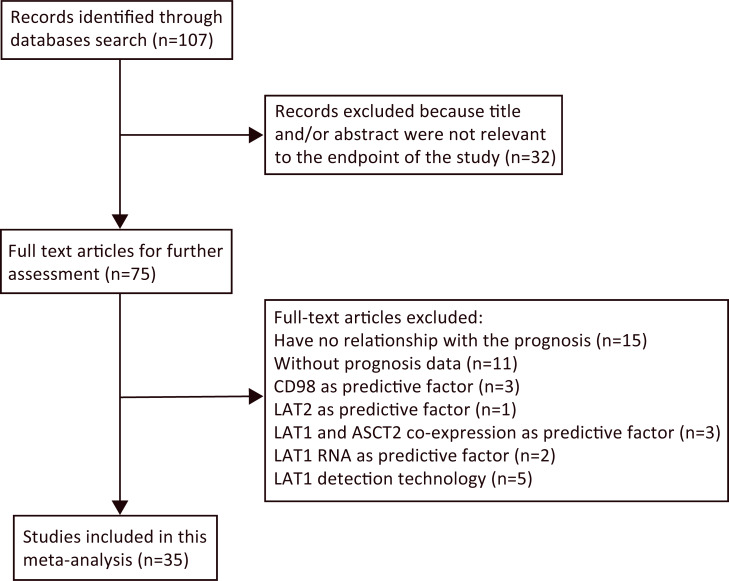
The flow chart of the selection process in our meta-analysis.